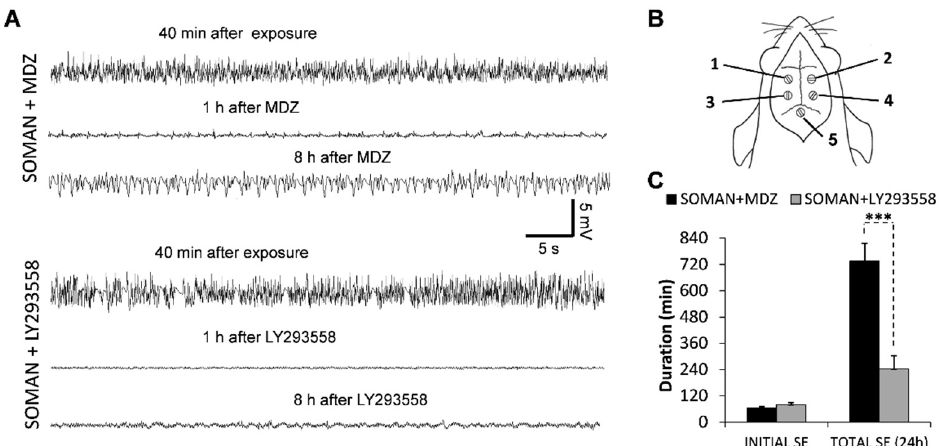
Figure 1. Intramuscular administration of midazolam (MDZ) or LY293558 stopped soman-induced SE within less than 30 min of administration, but seizures reoccurred significantly more in the MDZ- treated group. MDZ (5 mg/kg) or LY293558 (10 mg/kg) were administered at 1 h after injection of soman (1.2 × LD 50 ). Representative EEG traces at 40 min after soman exposure, as well as at 1 h and 8 h after administration of MDZ or LY293558 are shown in ( A ). Notice the persistence of low-amplitude epileptiform activity and the return of seizures in the MDZ-treated rats, but not in the LY293558-treated rats. Electrode placement for the recordings is shown diagrammatically in ( B) (1, two, three, and four, parietal electrodes; five, cerebellar reference electrode). The group data in ( C ) show the duration of the initial SE in each of the two groups and the total duration of SE throughout the 24 h period after soman exposure (*** p < 0.001, Independent Samples t -test). Sample sizes are n = eight for each of the two groups.